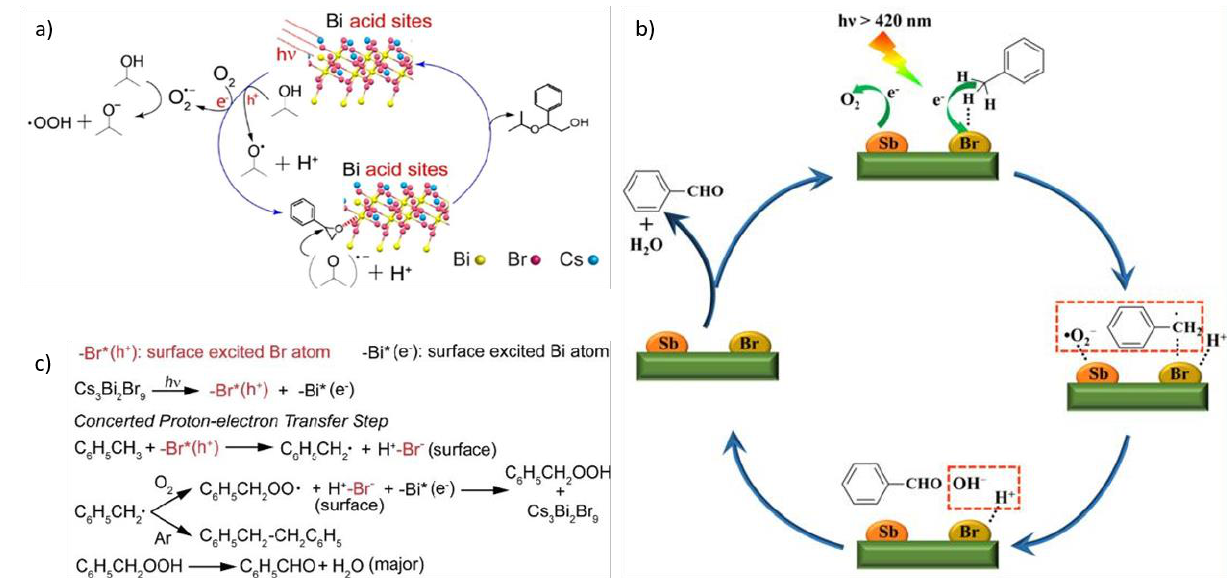
Figure 6. Proposed reaction mechanisms: ( a ) for the epoxyde alcoholysis reaction over Cs3Bi2Br9. For details, see ref. [43]. Reprinted with permission from ref [43]. Copyright 2019 ChemSusChem. ( b , c ) for the oxidation of toluene. For details, see refs. [44,45]. Reprinted with permission from refs.[44,45]. Copyright 2020 Angewandte Chemie International Edition. Copyright 2020 Angewandte Chemie International Edition.